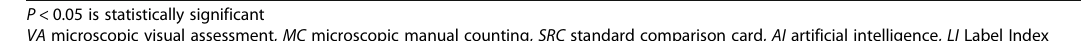
Table 3 Consistency analysis of pathologists using VA, MC, SRC and AI to interpret breast cancer Ki-67LI